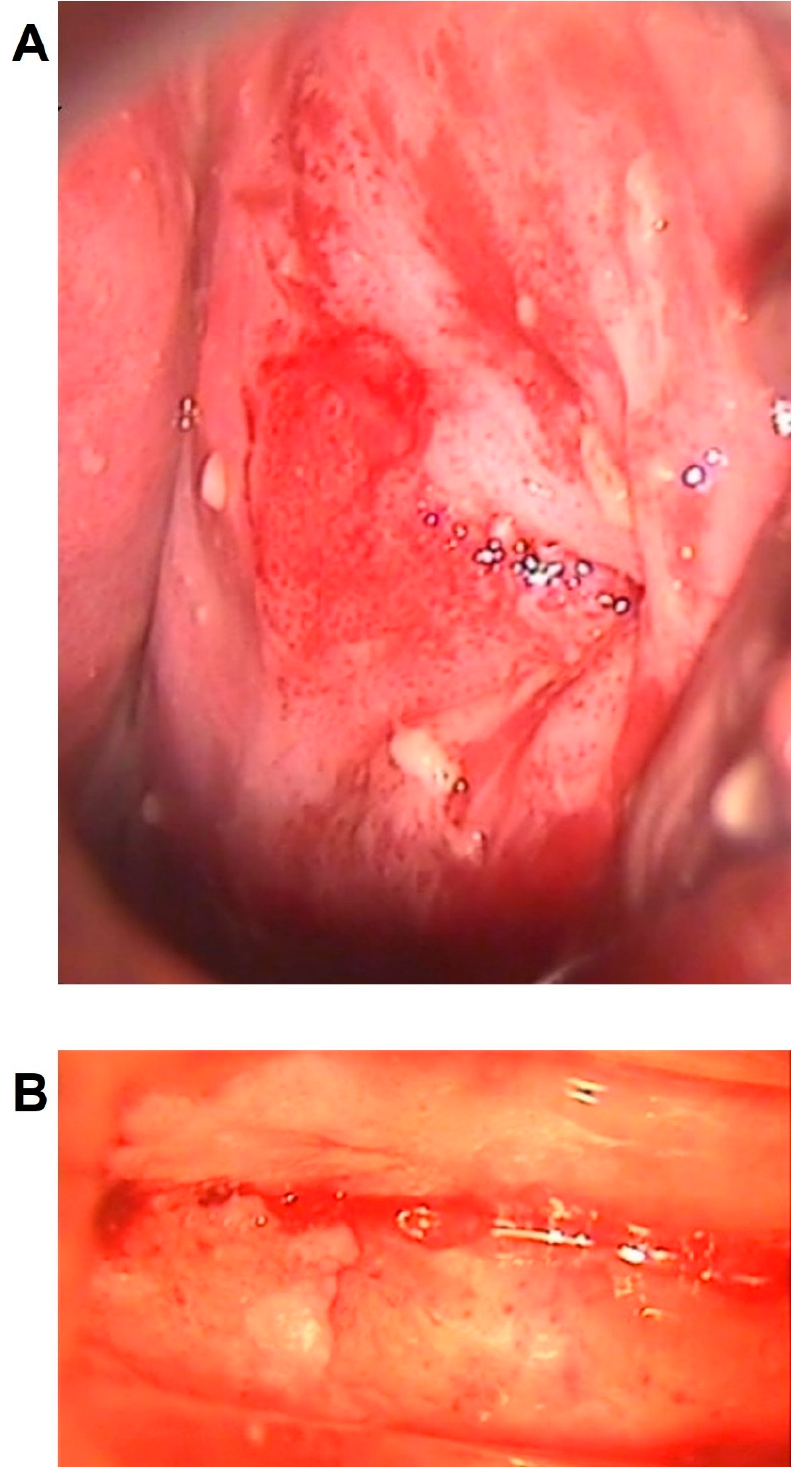
Figure 4. Colposcopic patterns associated with microinvasive VAIN3. Abnormal colposcopic findings of grade 2, vascular patterns and papillary lesions with regular ( A ) and/or irregular ( B ) surface in two women affected by VAIN3 with stromal microinvasion, both located at the vaginal vault, after previous hysterectomy for cervical cancer.